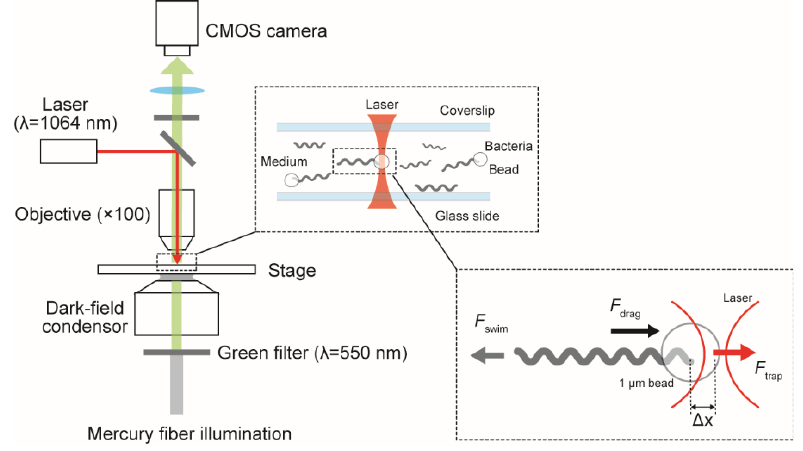
Figure 4. Measurement of swimming speed using optical tweezers. A microbead (1 μ m in diameter) attached to a swimming bacterium is trapped by a laser. Swimming force ( 𝐹 swim ) is determined from the bead displacement ( ∆𝑥 ), drag force exerted on the bacterium ( 𝐹 drag ) , and trap force ( 𝐹 trap ) [20].